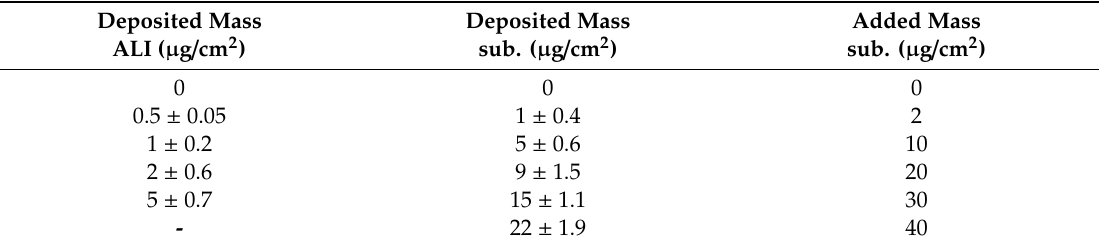
Table 1. The deposited mass of CeO 2 NPs (mean of 4 transwell inserts ± SD) at ALI and submerged (sub.) conditions, determined by means of ICP-MS after 24 h. Added mass refers to the weighed amount of CeO 2 .